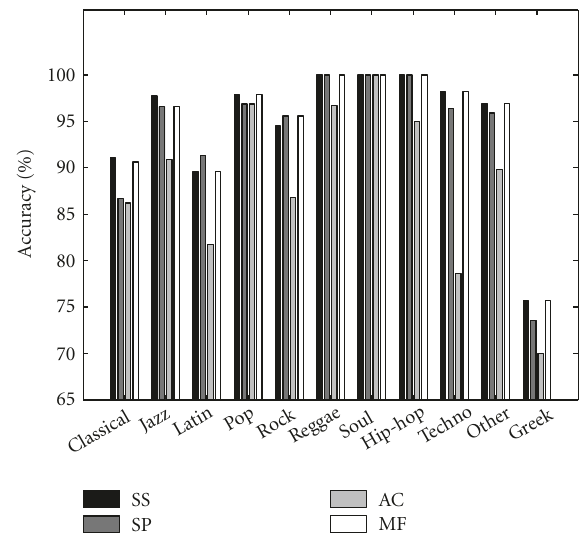
Figure 11: On the influence of the window overlap.